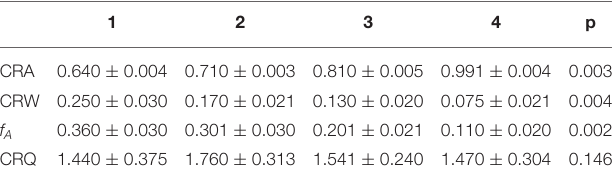
TABLE 2 | Cardiopulmonary Resonance Indices for the 4 cases of breathing: free breathing and 3 paced breathing at frequency of 0.33, 0.26, and 0.12Hz.